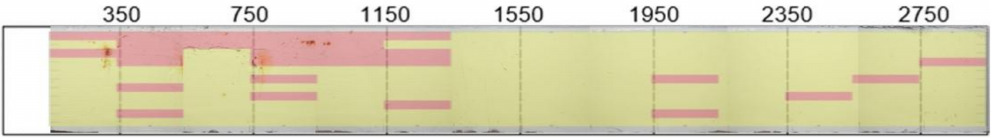
Figure 13. Damage detection with 34 training points, 40 hidden layer neurons, and 100